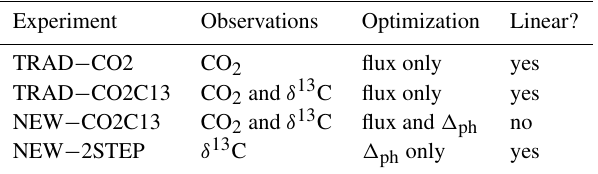
Table 2. Summary of the four inversion experiments, the observa- tions used, the optimized items (ocean and land fluxes, and (cid:49) ph ), and their linearity. The prefix TRAD − refers to traditional, i.e., ex- periments that have been performed in the past in any way, shape or form. The prefix NEW − refers to a new type of inversions used in this publication. NEW − CO2C13 used the default CTDAS-C13 model setup as described in the Methodology, while NEW − 2STEP solved for (cid:49) ph using only δ 13 C